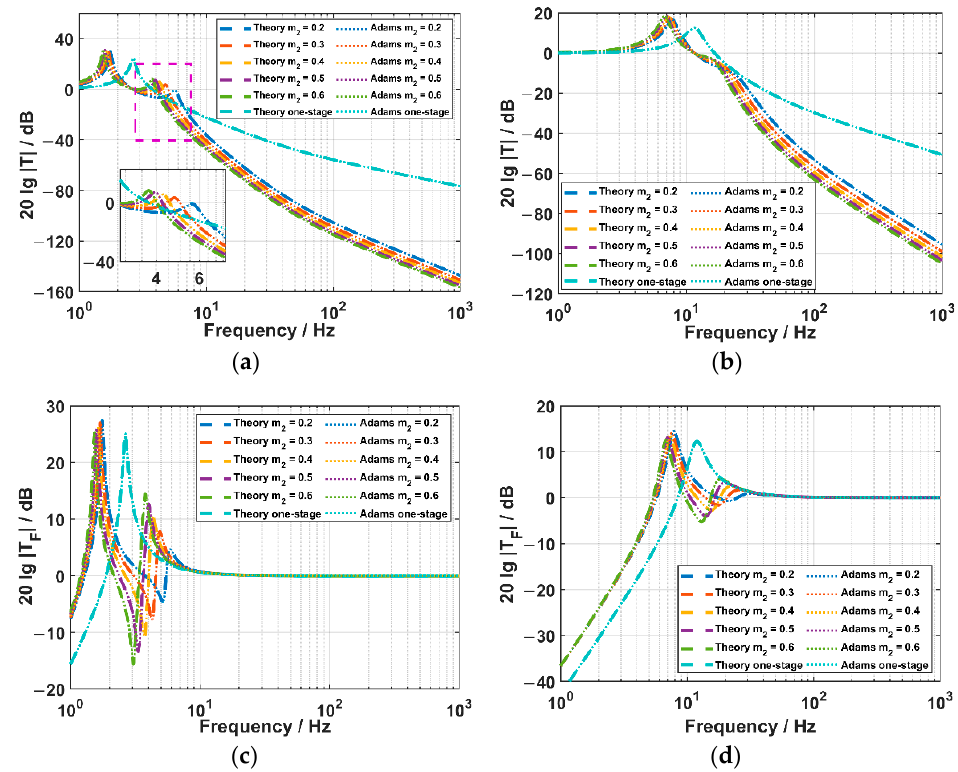
Figure 11. The spectra of the two suspension systems: ( a ) The X or Y acceleration transmissibility spectra of the OSSS and TSSS; ( b ) the Z acceleration transmissibility spectra of the OSSS and TSSS; ( c ) the X or Y acceleration response spectra of the FOVHs in the OSSS and TSSS; and ( d ) the Z acceleration response spectra of the FOVHs in the OSSS and TSSS.